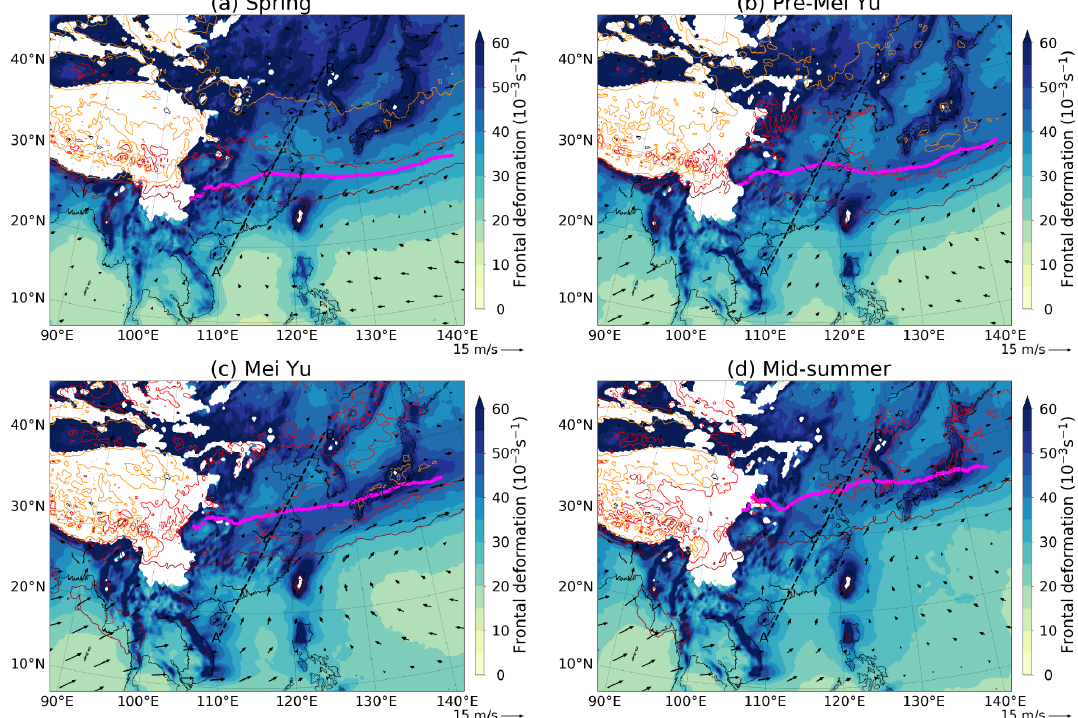
Figure 6. Dekadal mean of front deformation at 850hPa (shading; 10 − 3 s − 1 ) and at 500hPa (brown, red, and orange contours indicating 35, 42.5, and 50 × 10 − 3 s − 1 , respectively), wind vectors at 850hPa (arrows; ms − 1 ). The magenta line indicates the climatology of the mean dekadal location of the EASMF at 850hPa. The AB dashed black line indicates the transect of the vertical cross-section in Fig. 10. The dekads representing the four stages of EASM progression (first dekad of May, first dekad of June, third dekad of June, second dekad of July, respectively) are selected according to Fig. 3. All values are masked out at levels below the ground. Data from ERA5 1979–2018